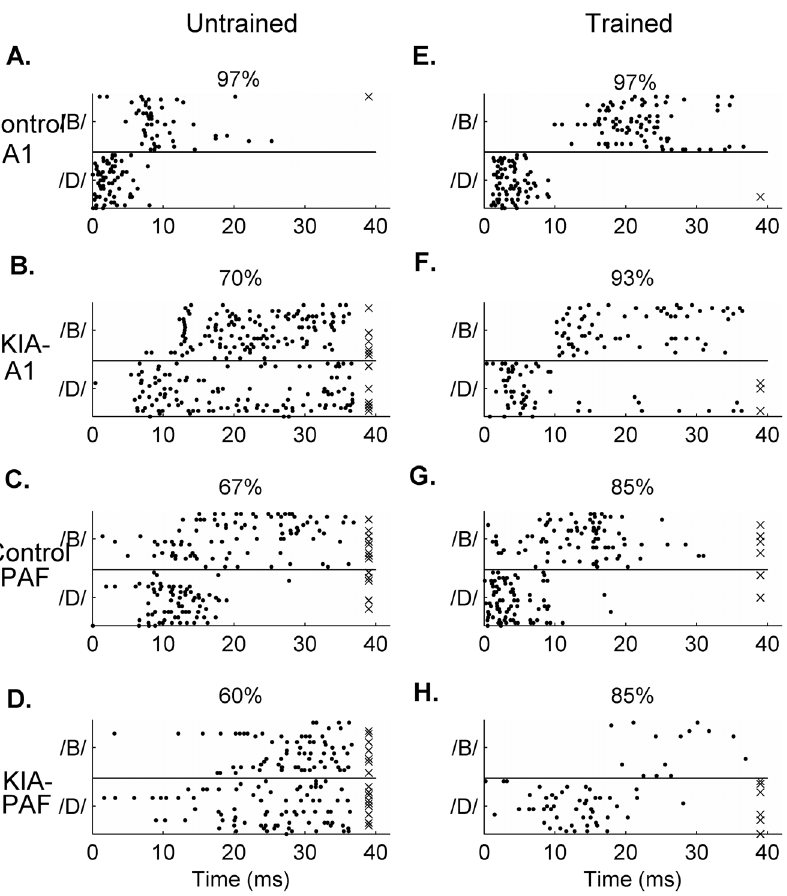
Figure 6. Training improves firing reliability in response to consonant speech sounds. Single site examples of neural responses to the consonant sounds /d/ and /b/ in every field before and after training. Classifier performance for each site is plotted on top of each panel, and trials which the classifier guessed incorrectly are marked by an ‘x’. A–D . Representative examples of single site responses to the consonants /b/ and /d/ in A1 and PAF of untrained control or KIA- rats. E–F . Representative examples of single site responses to the consonants /b/ and /d/ in A1 and PAF of control or KIA- rats after training was complete.